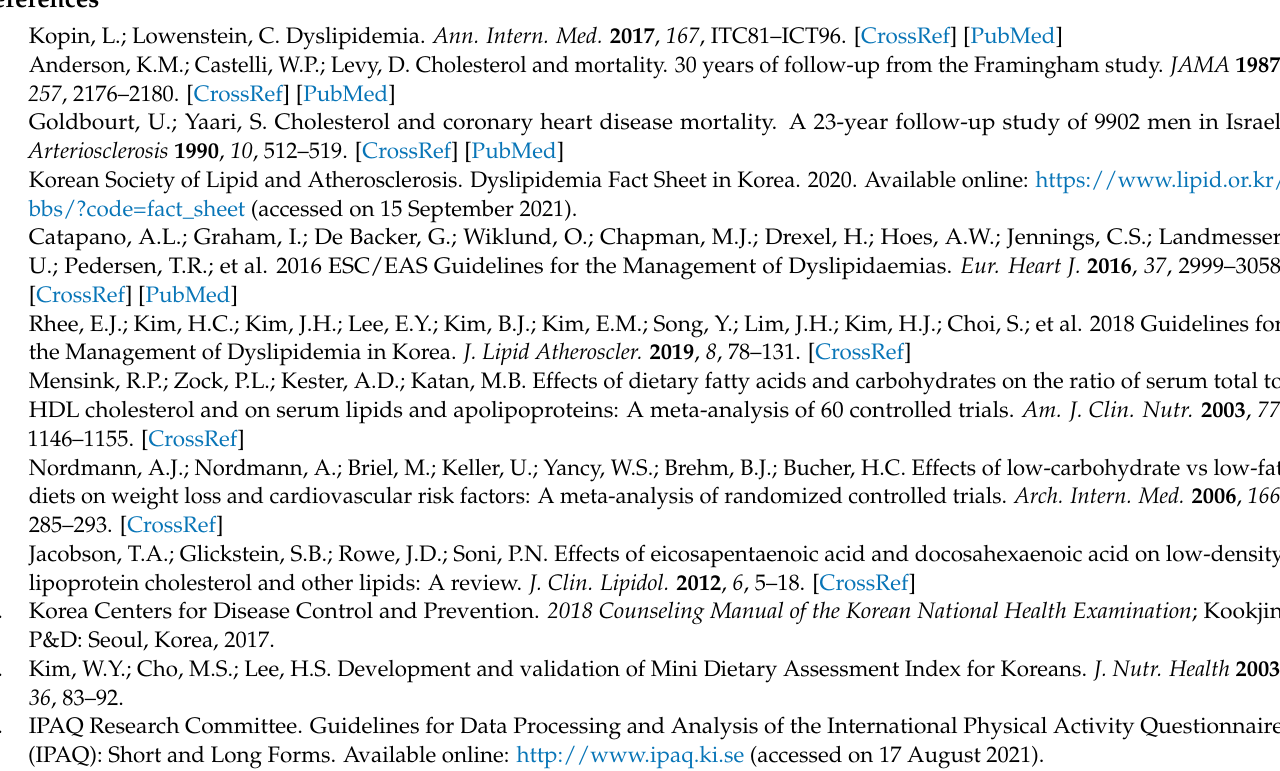
Koreans, Table S2: Baseline characteristics of the 284 study participants with and without controlled TG at 6 months, Table S3: Baseline characteristics of the 284 study participants with and without controlled TC at 6